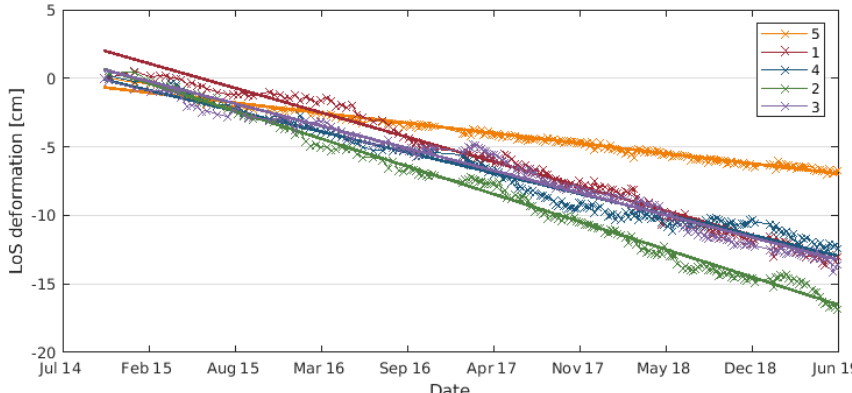
Figure 8. Time series of some selected points (see Fig. 6 for location) from the analysis of Sentinel-1 descending